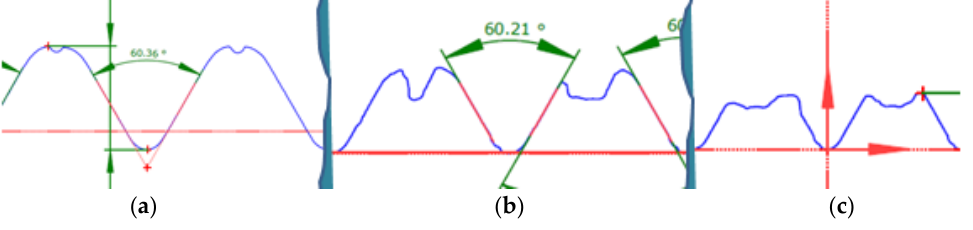
Figure 3. Thread section profile for a new tool ( a ), a used tool ( b ) and a broken tool ( c ).